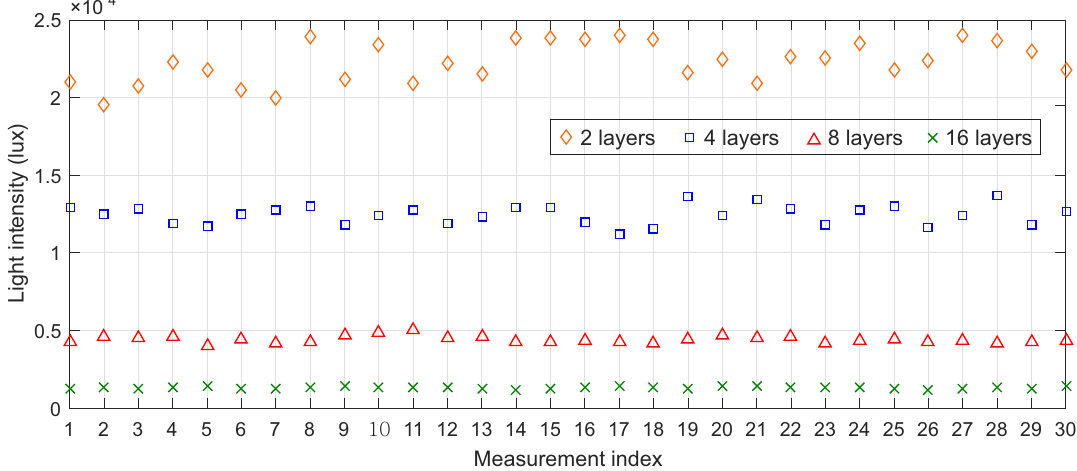
Figure 8. Light intensity after passing through 2, 4, 8, and 16 transparent plastic sheets in 30